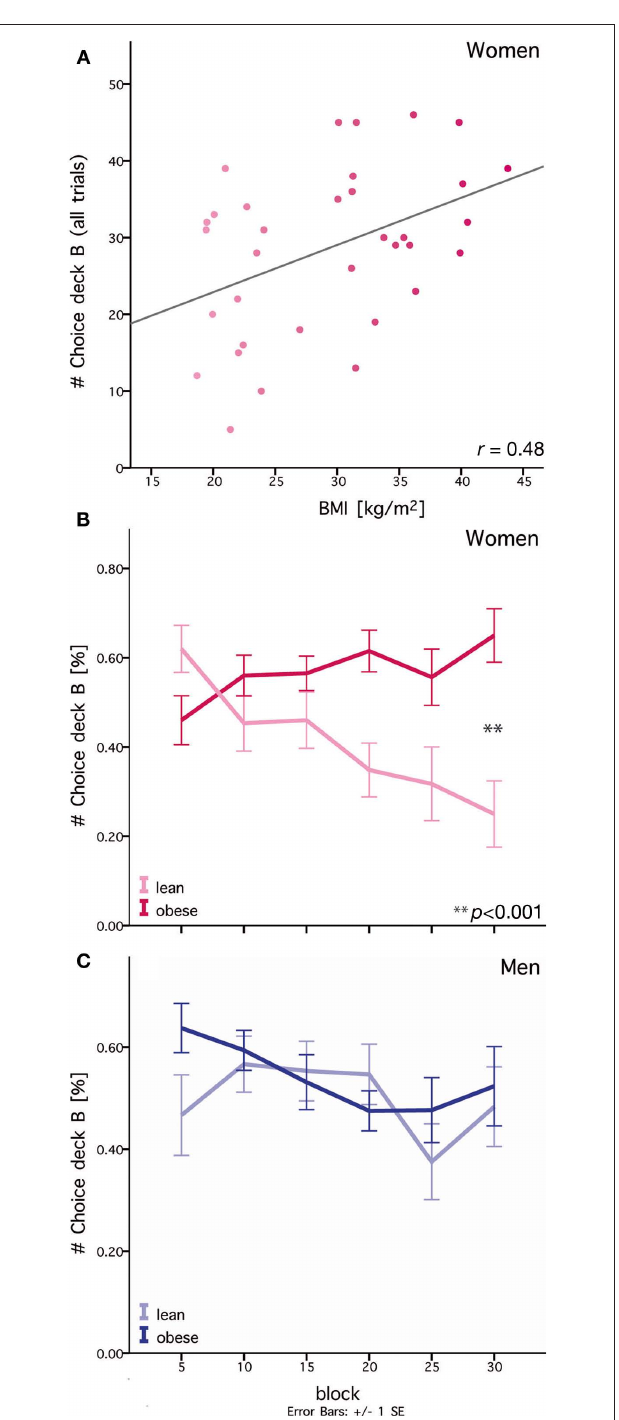
FIgure 4 | Differences in lean and obese women in their ability to adjust choice behavior to match long-term goals. (A) Preference for deck B over all trials correlates with BMI within the group of women. Gray line: linear regression. (B) Difference between lean and obese women in choice behavior during learning. Lean women learn to gradually select fewer cards from deck B. In contrast, obese women continue to select cards from deck B. Each block consists of five trials. (C) No difference between lean and obese men in choice behavior is observable during learning. Each block consists of five